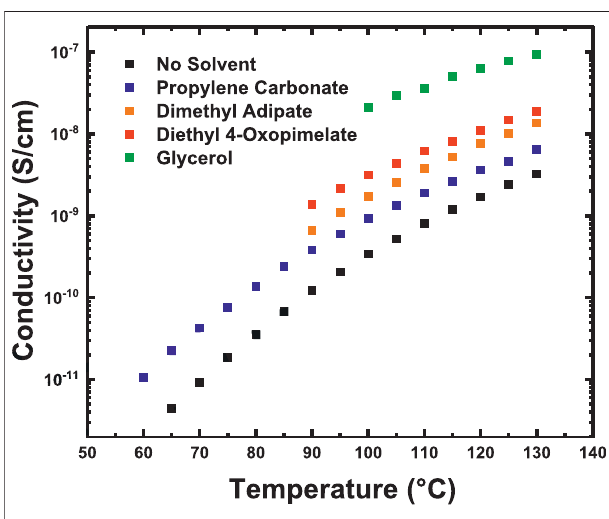
FIGURE 4 | Conductivity of the solvated sodium-ion conducting membranes as a function of temperature taken from dielectric relaxation